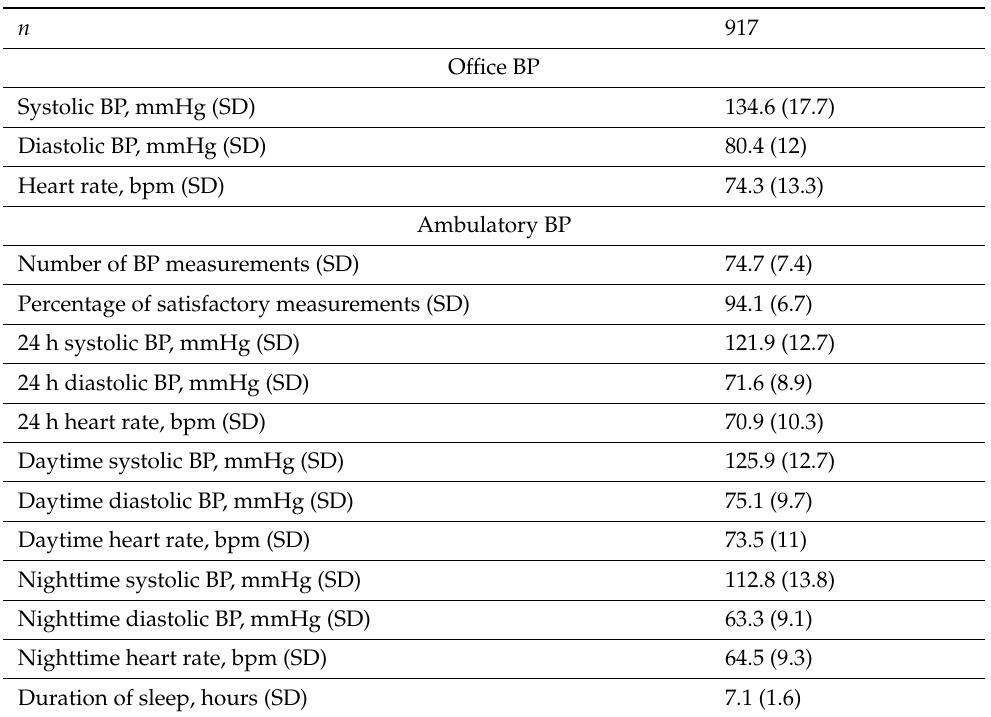
Table 2. Blood pressure